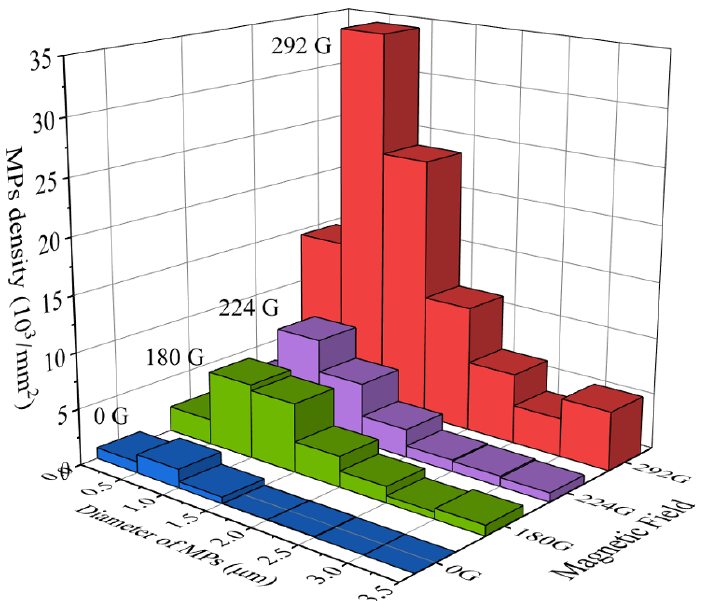
Figure 4. Distributions of MP density under different magnetic fields: (a) 0 G; (b) 180 G; (c) 224 G; and (d) 292 G.